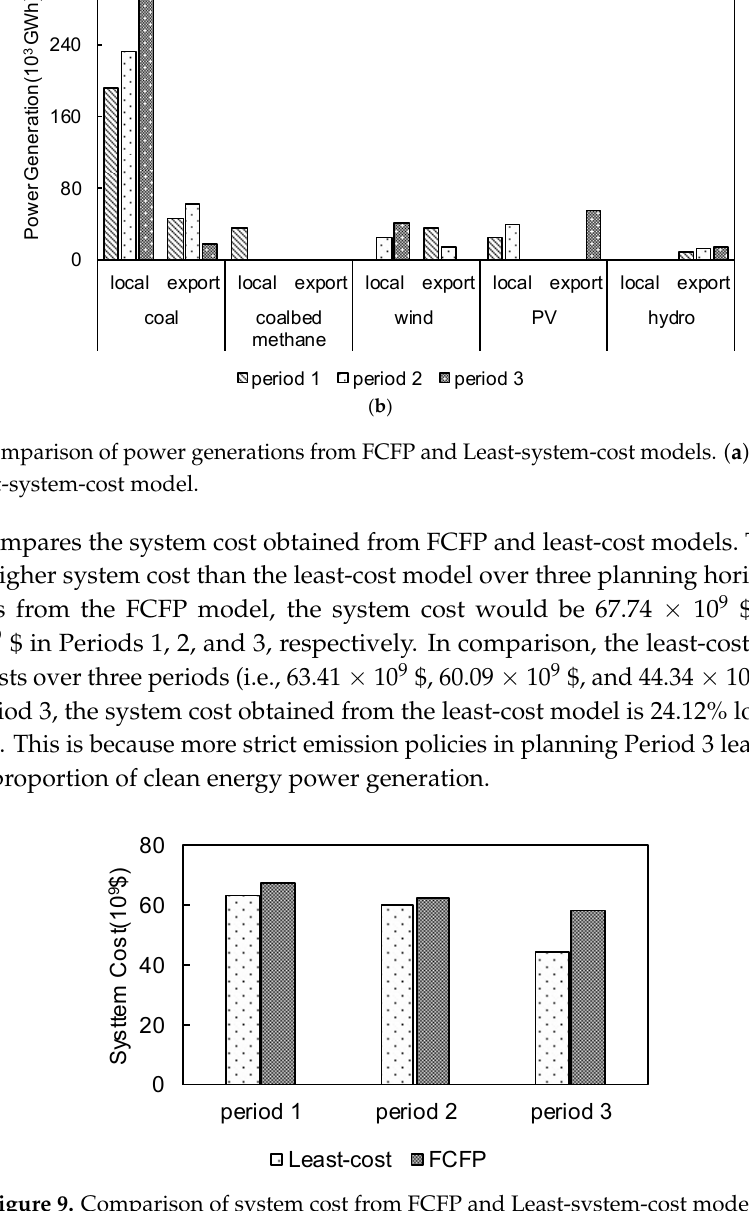
Figure 9. Comparison of system cost from FCFP and Least-system-cost models.